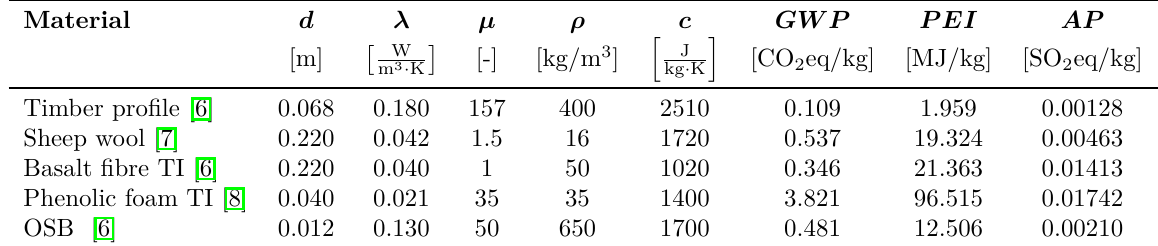
Table 1. Layer materials of both assemblies and their main characteristics.